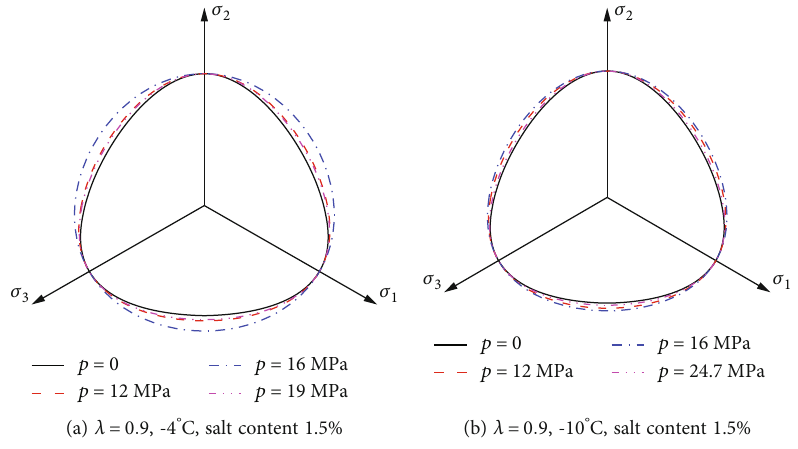
Figure 8: Shape curves in deviatoric plane at di ff erent values of p